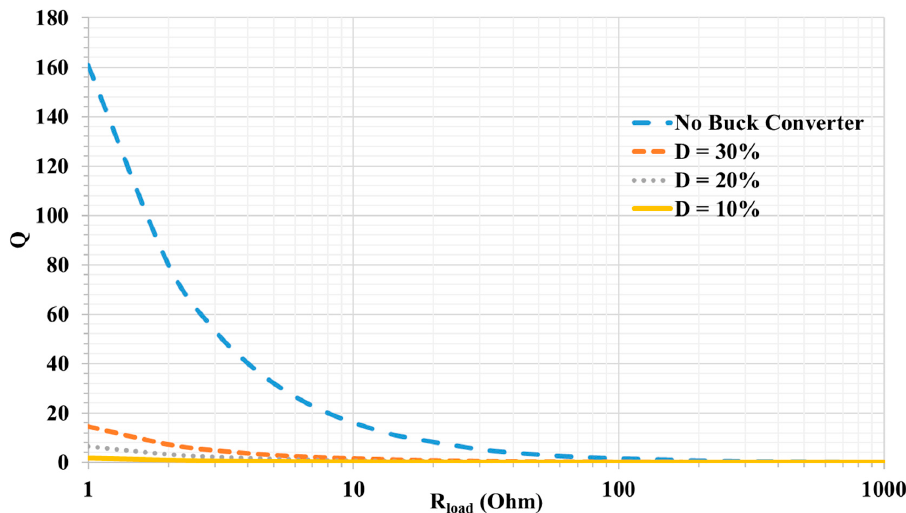
Figure 7. Q value change with the load.